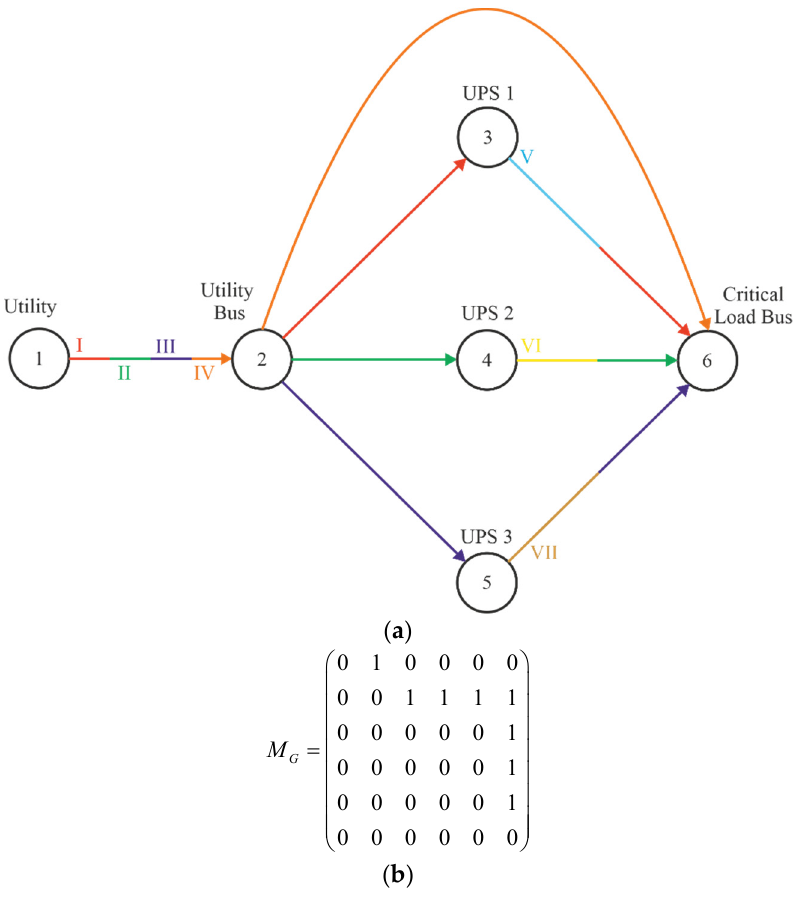
Figure 8. Configuration of Parallel System: ( a ) Oriented graph; ( b ) Adjacency matrix.